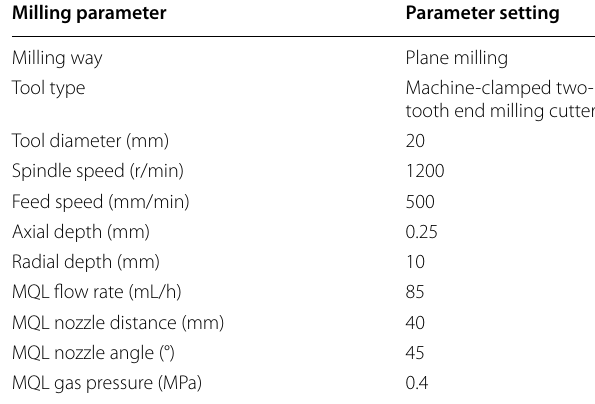
Table 2 Mechanical properties of Grade 45 steel